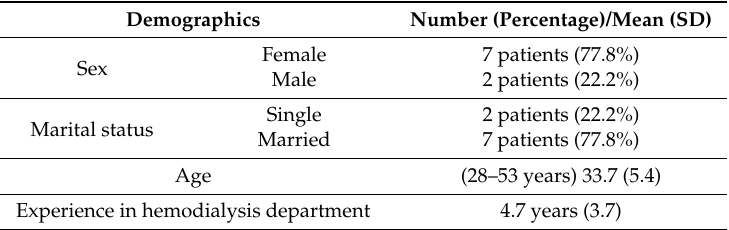
Table 1. Demographic characteristics of participants (nurses in hemodialysis department).